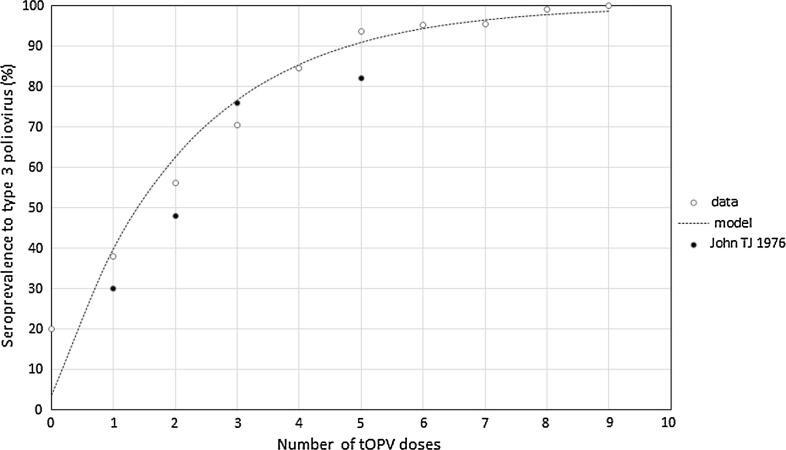
Seroprevalence of anti-poliovirus type 3 antibodies by number of OPV doses compared with binomial maximum likelihood model. Estimates reported by John TJ 1976 [16] from the same area are shown by way of comparison.